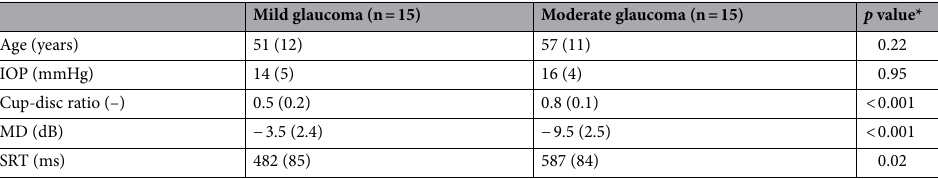
Table 4. Demographics and data summary of the glaucoma group from Evaluation of SRT in hemi-field sectors phase study population. Data expressed as mean (SD); Type I error was kept at 5% level and two-tailed tests were used. IOP, intra-ocular pressure in mmHg; MD, mean deviation from standard automated perimetry in decibel (dB); SRT, saccadic reaction time from eye movement perimetry in milliseconds (ms); *Independent T-test.